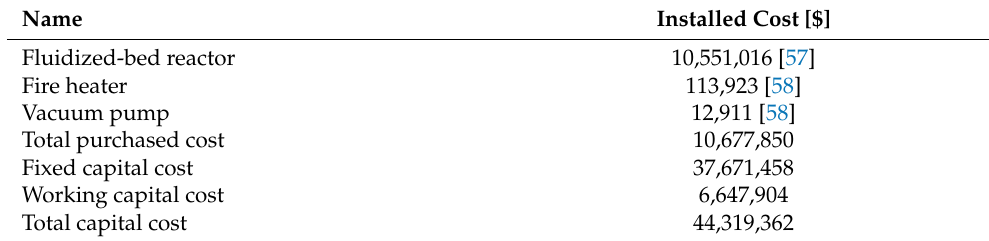
Table 7. Scenario 1 fluidized-bed plant total capital cost.